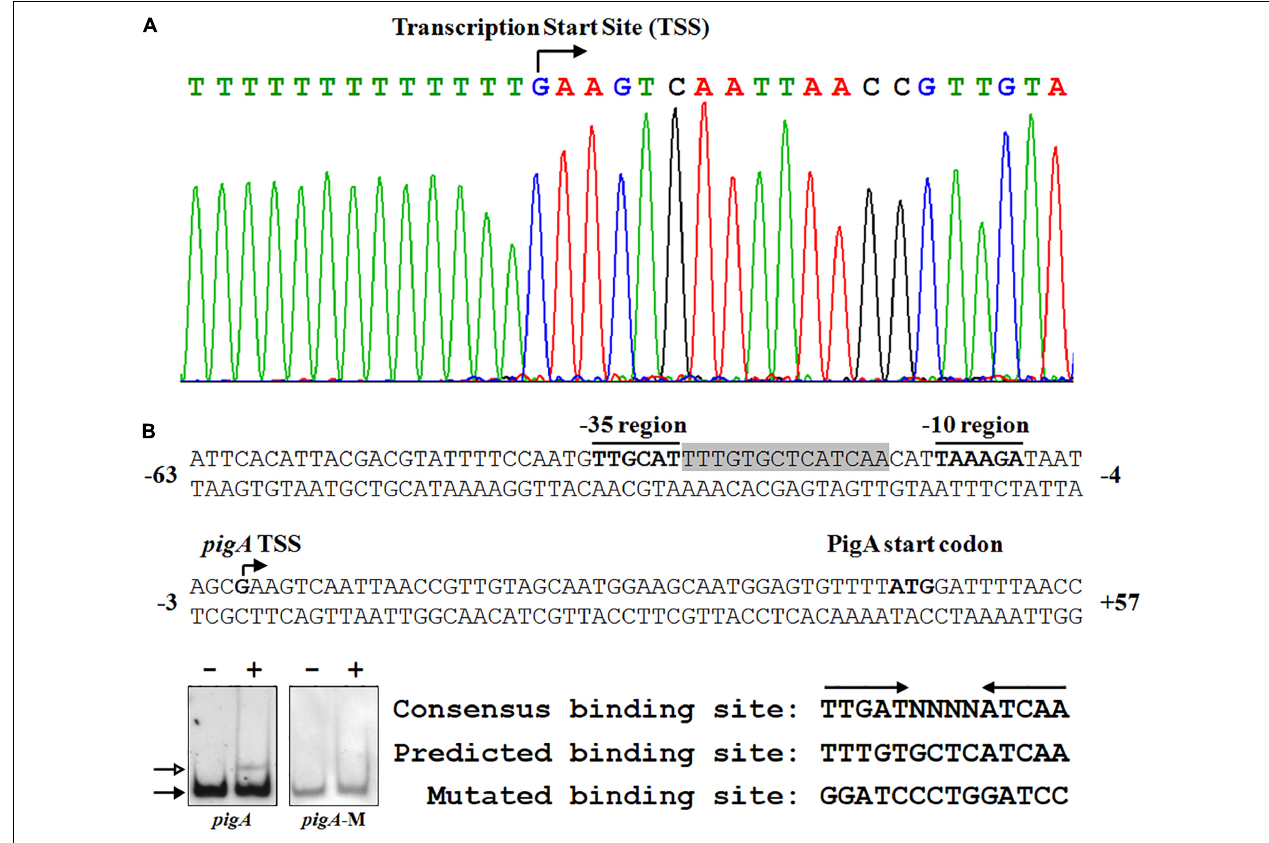
FIGURE 4 | Identification of the Fnr binding site in the pig promoter. (A) Identification of the pig gene transcription start site (TSS) using a 5 (cid:48) -RACE assay (top), and the nucleotide sequence of the pig promoter region (bottom). The PigA start codon, pigA TSS, and the – 10 and – 35 regions are highlighted in bold. The fnr binding site is shown in shadow. The numbers indicate the distance (shown in nt, – represents upstream, and + represents downstream) to the TSS (+1). (B) Identification of the Fnr binding site. EMSA analysis of the binding between the Fnr and pig promoter probes ( pigA ) and the mutant pig promoter probe ( pigA -M) (Left). Comparison between the conserved Fnr binding motif, predicted Fnr binding sites in the pig promoter, and the mutated nucleotide sequence (Right). Lane – : No protein was added to the reaction mixture. Lane +: 500 nM His 6 -Fnr was added to the reaction mixture. Each lane contains 0.2 nM-labeled DNA probe. The solid and hollow arrows indicate the free probe and shifted probe,